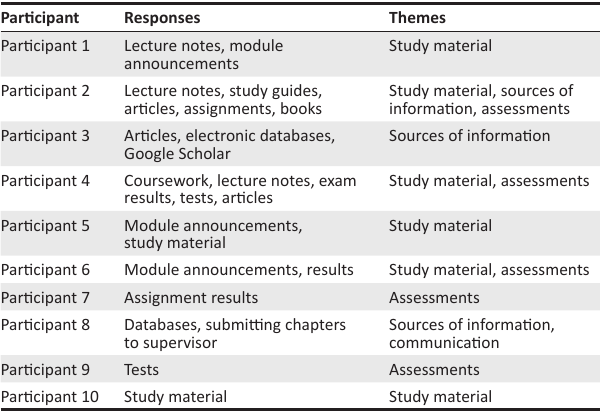
TABLE 2: Interview responses and themes on information accessed on smart devices.